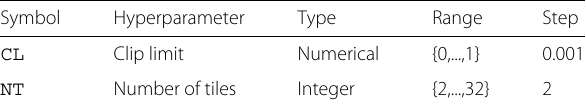
Table 1 Hyper-space considered in our